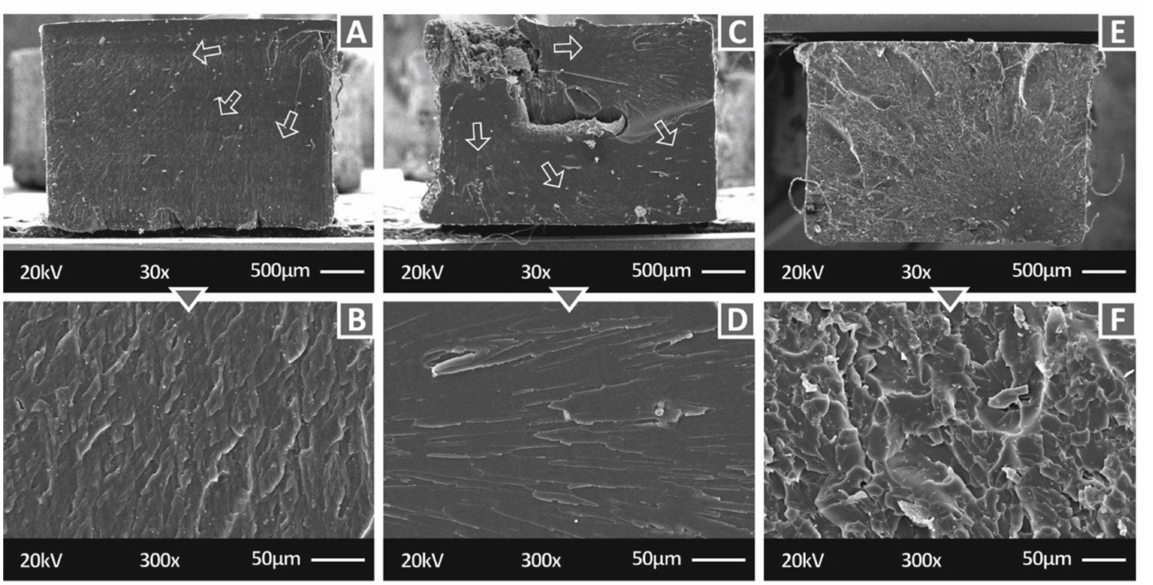
Figure 7. SEM images of the fracture surfaces of the specimens: ( A ) Biomed Clear 1 wt.% CNF and 1 wt.% Cu 30 × , ( B ) Biomed Clear 1 wt.% CNF and 1 wt.% Cu 300 × , ( C ) Biomed Clear 1 wt.% Cu 2 O 30 × , ( D ) Biomed Clear 1 wt.% Cu 2 O 300 × , ( E ) Biomed Clear 1 wt.% CNF and 1 wt.% Antibacterial Powder, 30 × , and ( F ) Biomed Clear 1 wt.% CNF and 1 wt.% Antibacterial Powder, 300 × . Arrows indicate the crack propagation on the fracture area for the two materials.